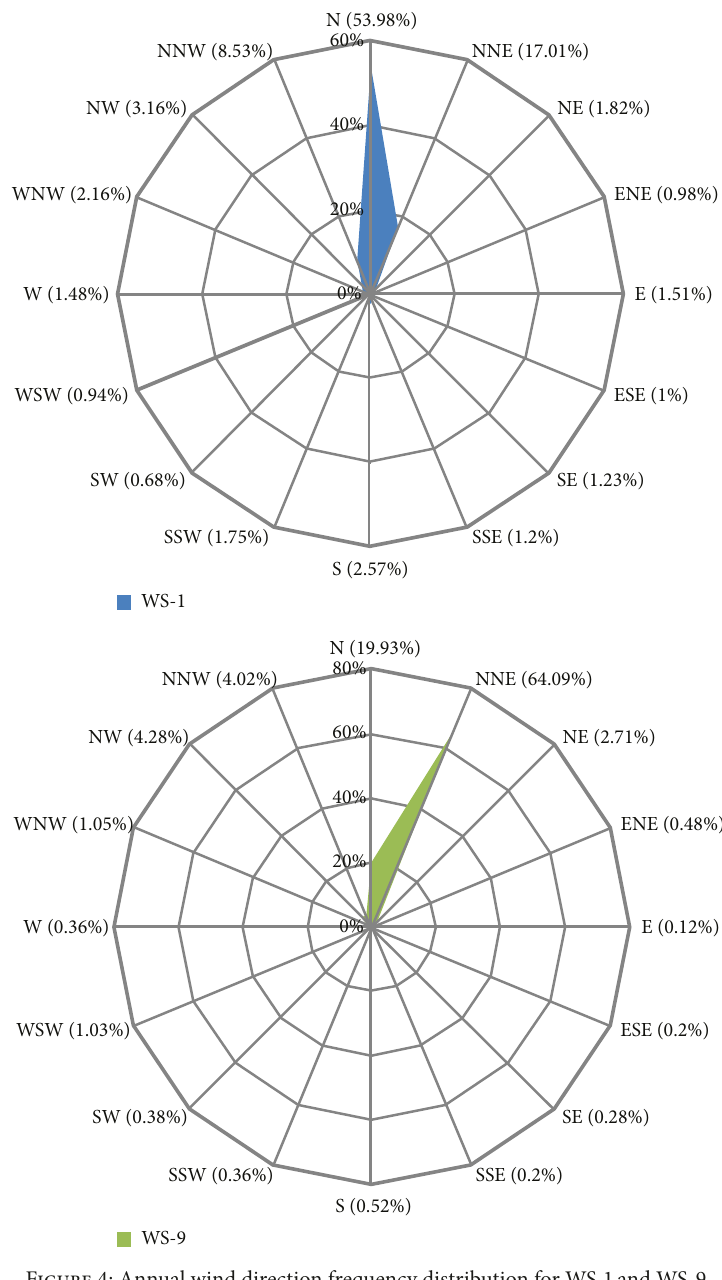
Figure 4: Annual wind direction frequency distribution for WS-1 and WS-9.